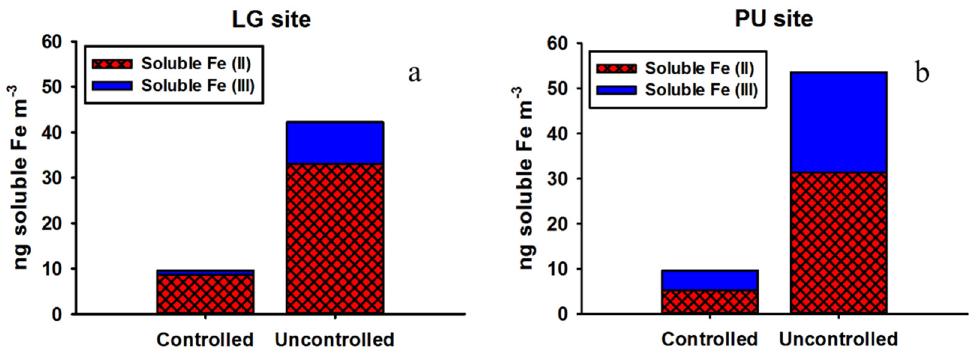
Figure 5. Soluble fractions of Fe(II) and Fe(III) at: ( a ) LG site; and ( b ) PU site.